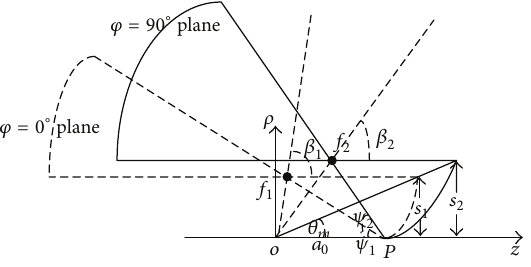
Figure 2: Parameters in long and short axis